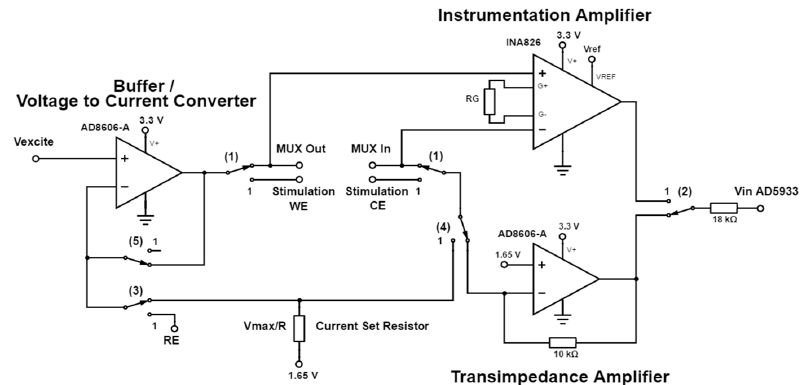
Figure 5. Impedance excitation circuit allowing voltage (two or three electrode setup) or current (two or four electrode setup) excitation of the system under test. (The current excitation signal in galvanostatic mode is defined using the current set resistance RSet = Vexcite_max / Iexcite_max). Table 3. Truth table of the switching protocol for switches (1) to (5) of Figure 5. Electrode